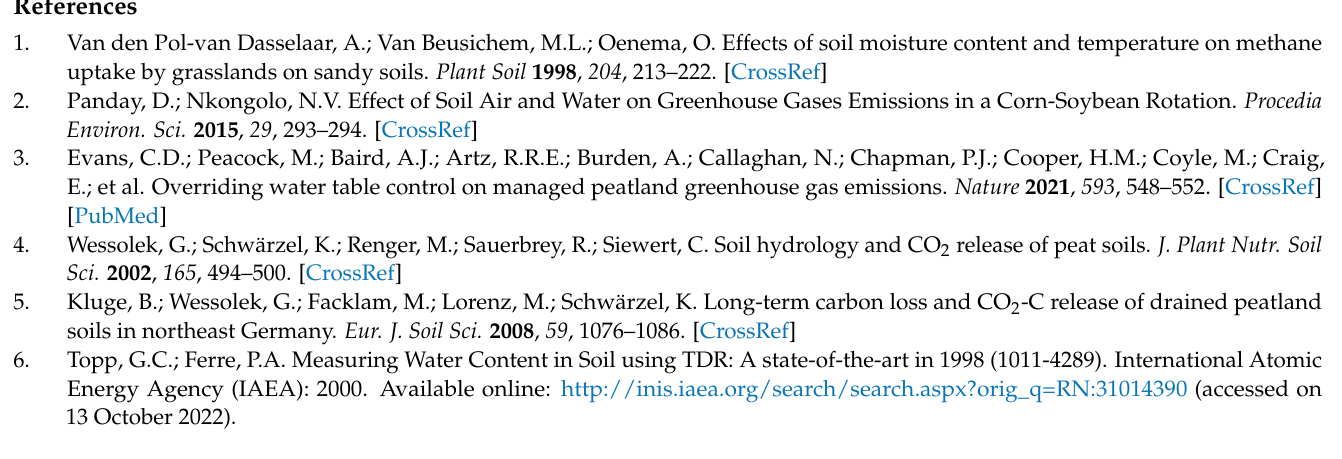
Figure S2: Difference between measured and corrected water contents across plots; Figure S3: Difference between measured and corrected water contents for each plot; Figure S4: 3D plot of the WK model; Figure S5: 3D plot of the WKI model; Figures S6–S13: Graphical outputs of the generalised